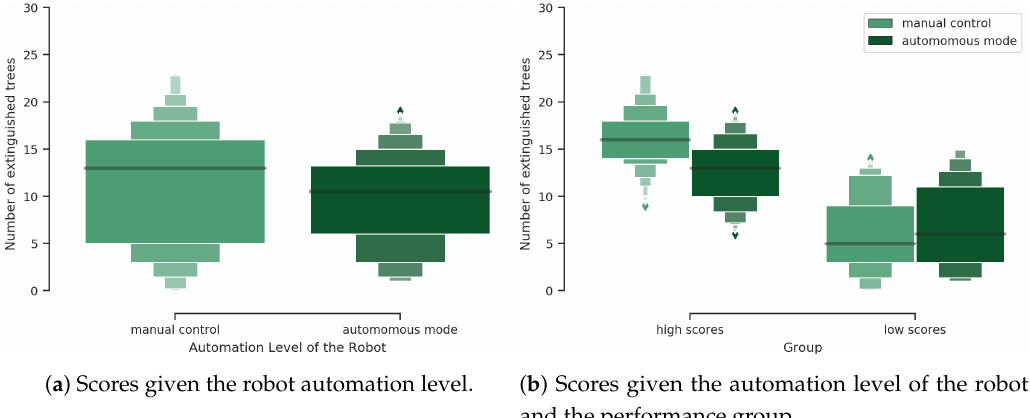
Figure 5. Score analysis given the automation level of the robot and the performance group.